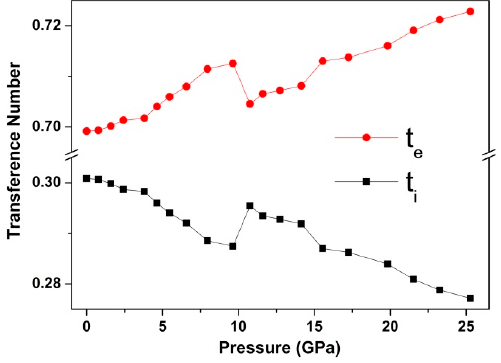
Figure 7. t i and t e under various pressures.